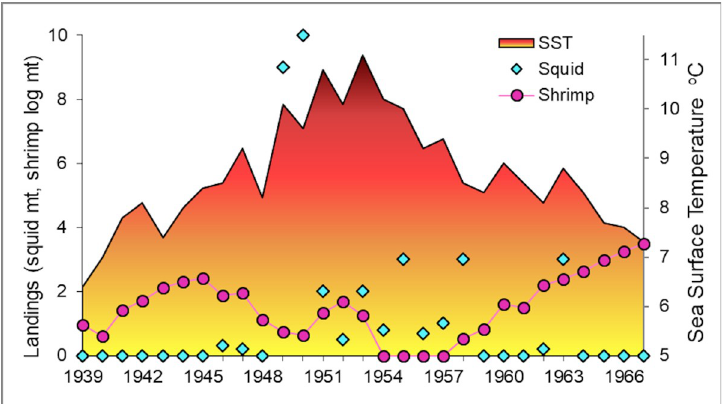
Fig 12. Maine longfin squid and northern shrimp landings and annual average sea surface temperature. Temperature recorded daily at Boothbay Harbor, Maine, 1939–1967. Squid landing units are mt, shrimp landings are in log(mt+1). Data from [21,